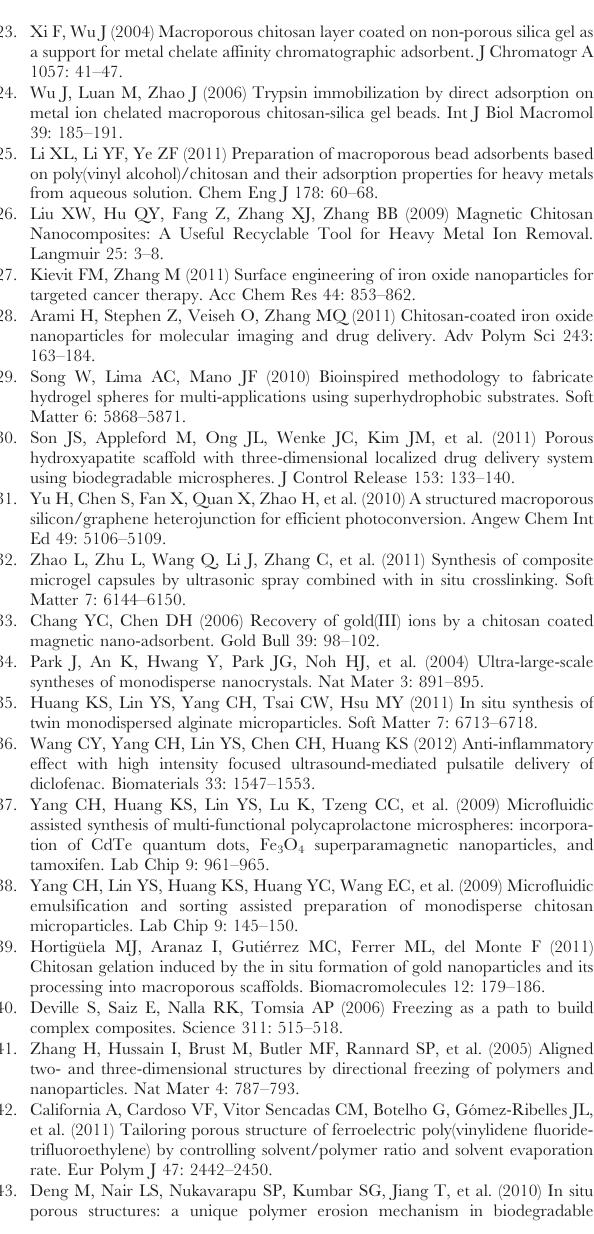
Figure S7 Pernicious biological properties test for the nanopar- ticle-loaded chitosan spheres. (a) The cytotoxicity of iron oxide nanoparticles-loaded chitosan spheres (5.4 6 1.7 nanometers of iron oxide nanoparticles (with 5% NaOH) inside chitosan spheres) with three cell lines. (b) The MTT assay data of various iron oxide nanoparticles loaded chitosan spheres (MCF-7 cells). Sample A: 5.4 6 1.7 nanometers of iron oxide nanoparticles (with 5% NaOH) inside chitosan spheres. Sample B: 4.4 6 0.9 nanometers of iron oxide nanoparticles (with 20% NaOH) inside chitosan